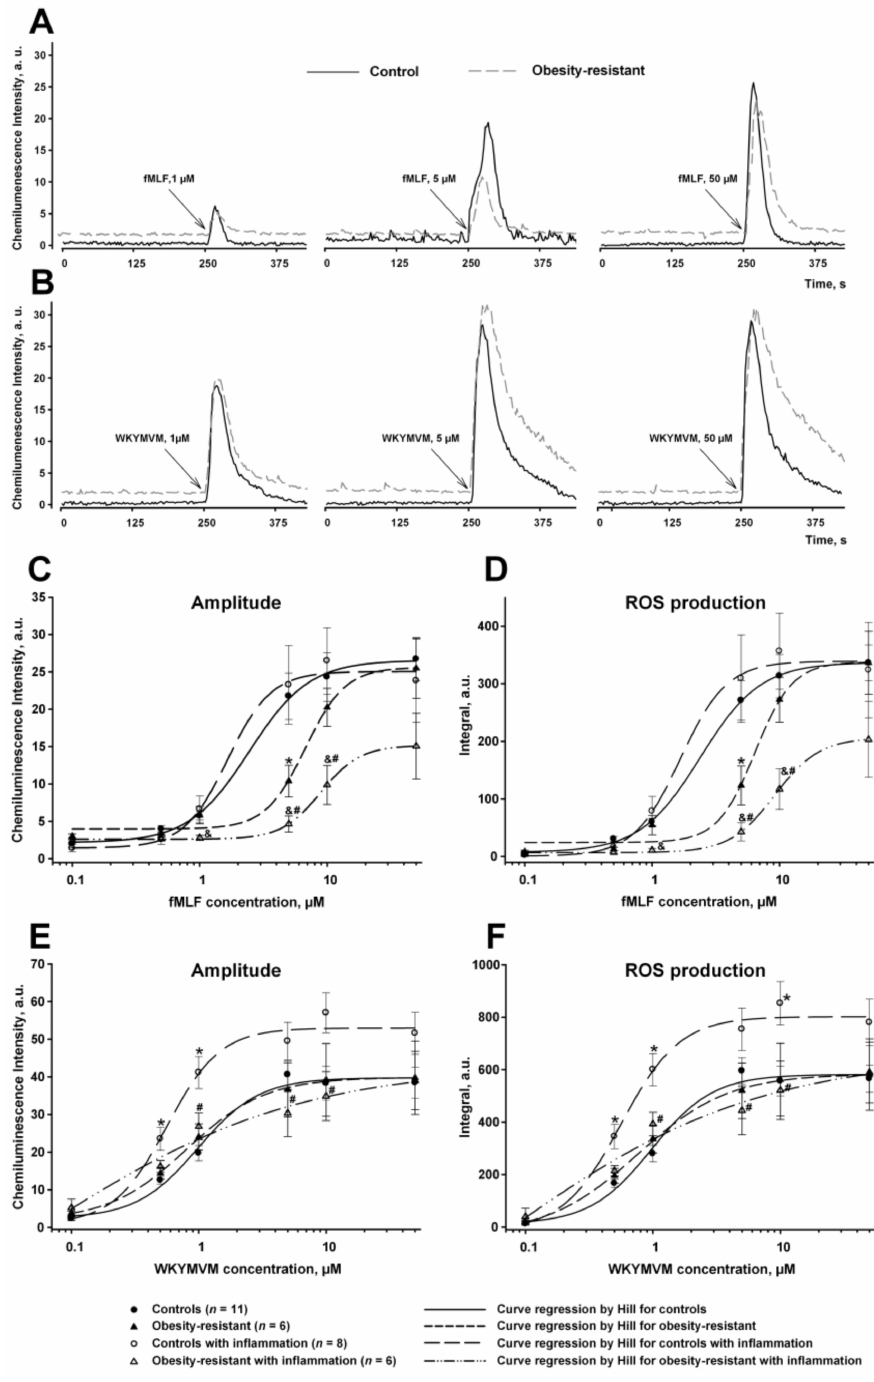
Figure 2. Dependences of the amplitude of response and the production of reactive oxygen species (ROS) on the concentrations of FPR agonists. ( A , B ) Experimental records of cell responses to fMLF and WKYMVM (1, 5, 50 µ M), respectively. ( C , D ) Kinetic parameters of fMLF-induced respiratory burst. ( E , F ) Kinetic parameters of WKYMVM-induced respiratory burst. Data are presented as mean ± SEM. Significant differences of parameters by ANOVA on ranks: * p < 0.05 compared to controls; # p < 0.05 compared to controls with inflammation; and & p < 0.05 between obesity-resistant mice with and without